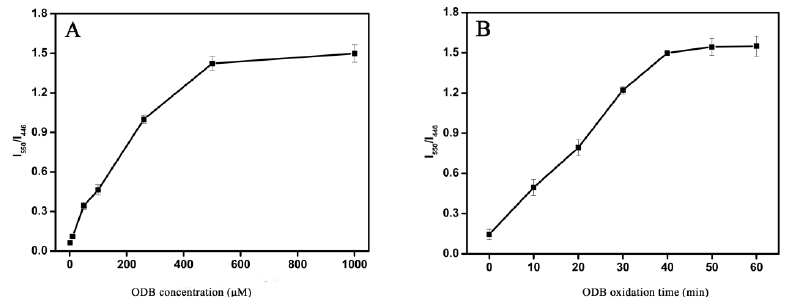
Figure 3. Optimization of main experimental parameters: ( A ) The effect of ODB concentration on the fluorescence ratio (I 550 /I 446 ); the glucose concentration is 200 μM. ( B ) The effect of ODB oxidation time on the fluorescence ratio (I 550 /I 446 ); the concentrations of glucose and ODB are 200 μM and 500 μM, respectively.